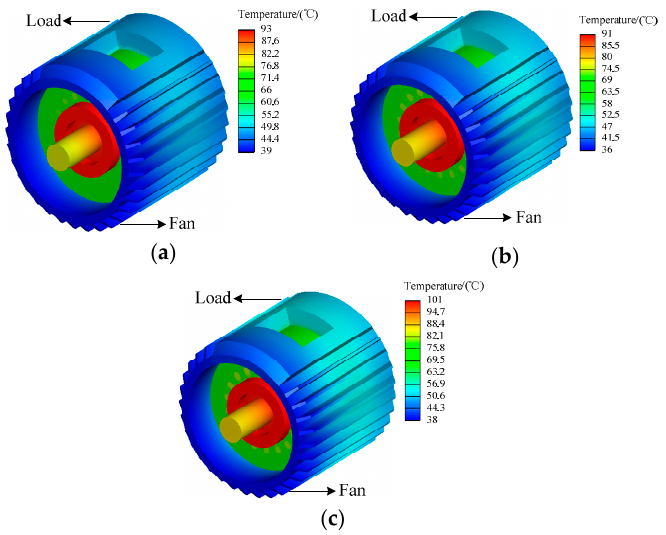
Figure 17. Temperature distribution of the motor: ( a ) Healthy motor cage; ( b ) One-broken-bar fault; ( c ) Continuous two-broken-bars.